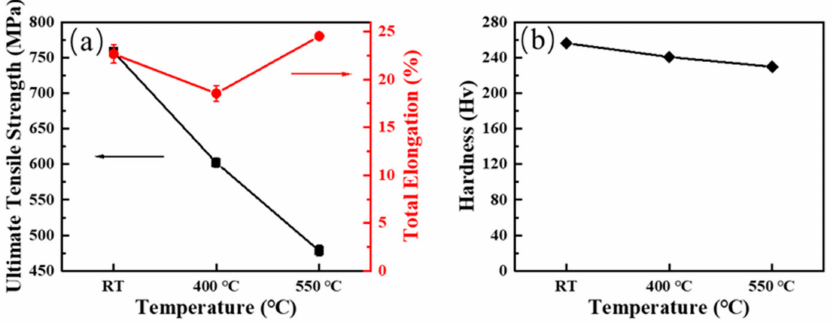
Figure 4. Variation of ( a ) ultimate tensile strength and total elongation, and ( b ) hardness with temperatures of 9Cr-F/M